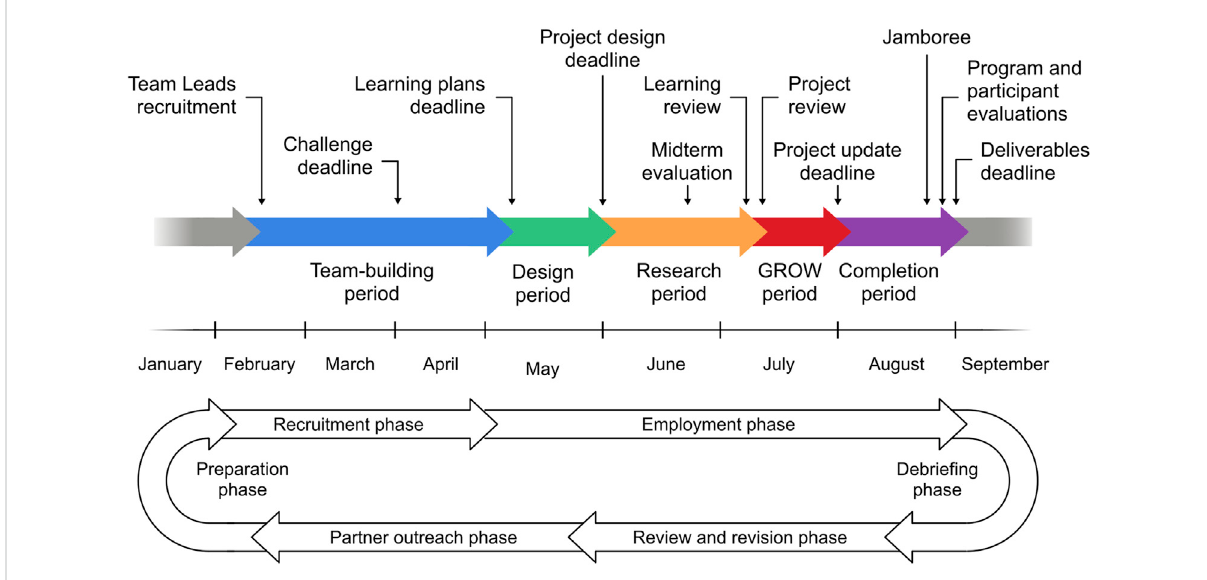
FIGURE 1 Program overview. Schematic illustration of milestones and timelines spanning a recruitment period from January to the end of April and an employment or work period from May to August. The recruitment phase and the fi rst week of the work period are dedicated to team building. The remaining employment period consists of a design period, a research review, a review/GROW period, and a completion period. The program ends with a debrie fi ng and a review and revision period. The planning for the following summer starts with a partner outreach period and is followed by a recruitment preparation